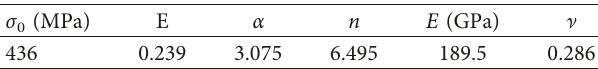
Figure 2: The SSRT experiment: (a) the test procedure for Alloy 600; (b) the installation position of the CT specimen. Table 2: Nickel-based Alloy 600 material mechanical properties at 340 ° C.